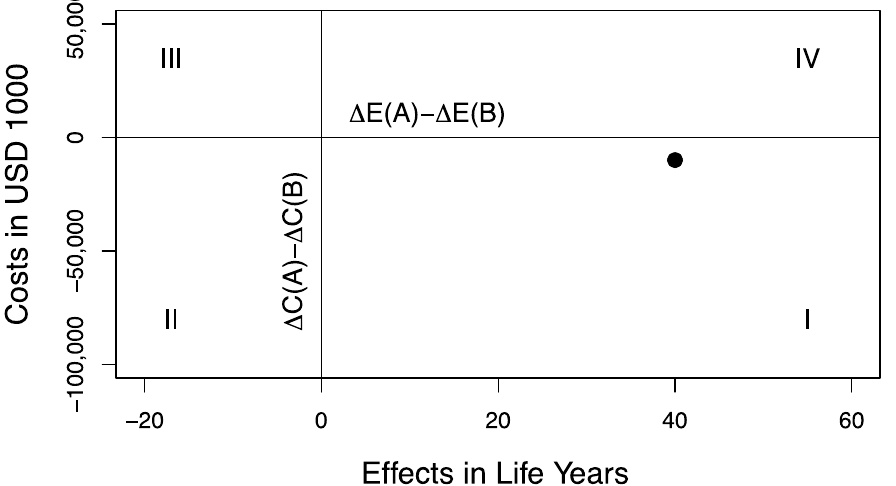
Figure 1. Decision-making plane. The dot in Quadrant I represents a healthcare resource reallocation policy that leads to a reduction of USD 10,000,000 in net costs and a net increase of 40 Life Years (see Table 1). This therefore reflects an unambiguous improvement in the allocation of scarce healthcare resources.